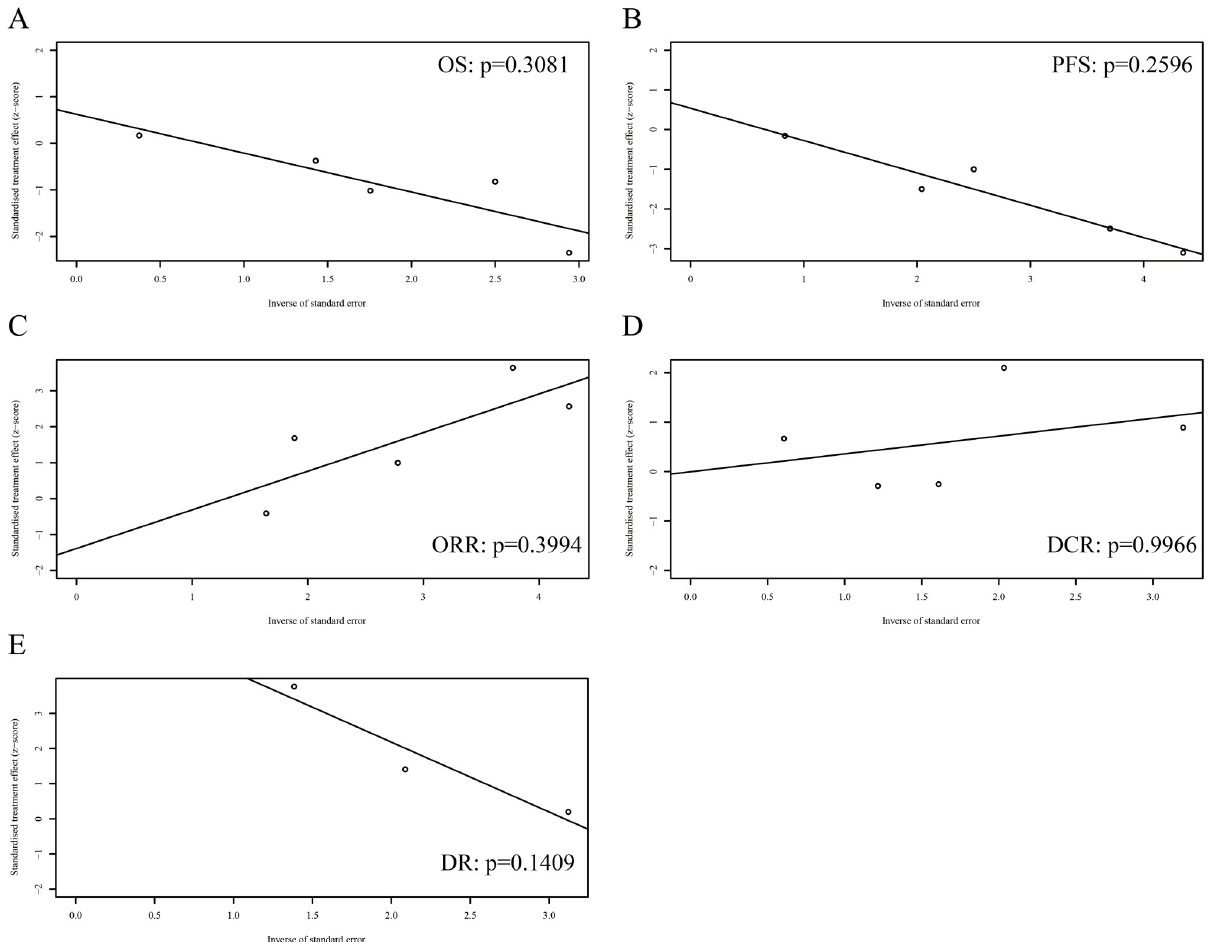
Fig 6. Egger’s tests for (A) overall survival (OS), (B) progression-free survival (PFS), (C) objective response rate (ORR), (D) disease control rate (DCR), and (E) discontinuation rate (DR).